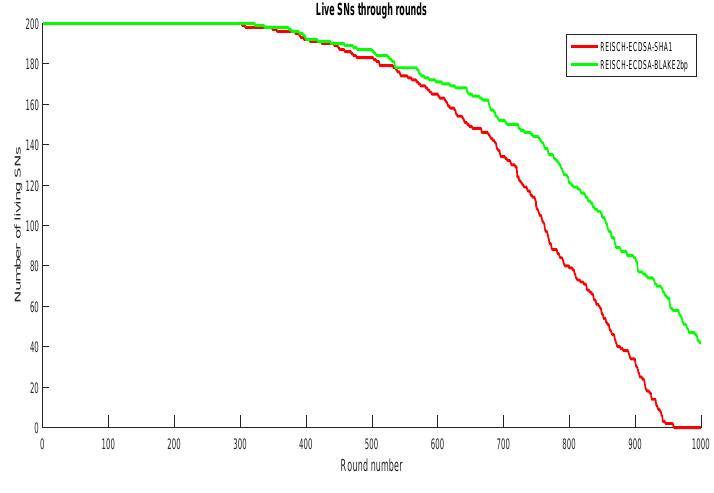
Figure 25. Comparison of alive SN